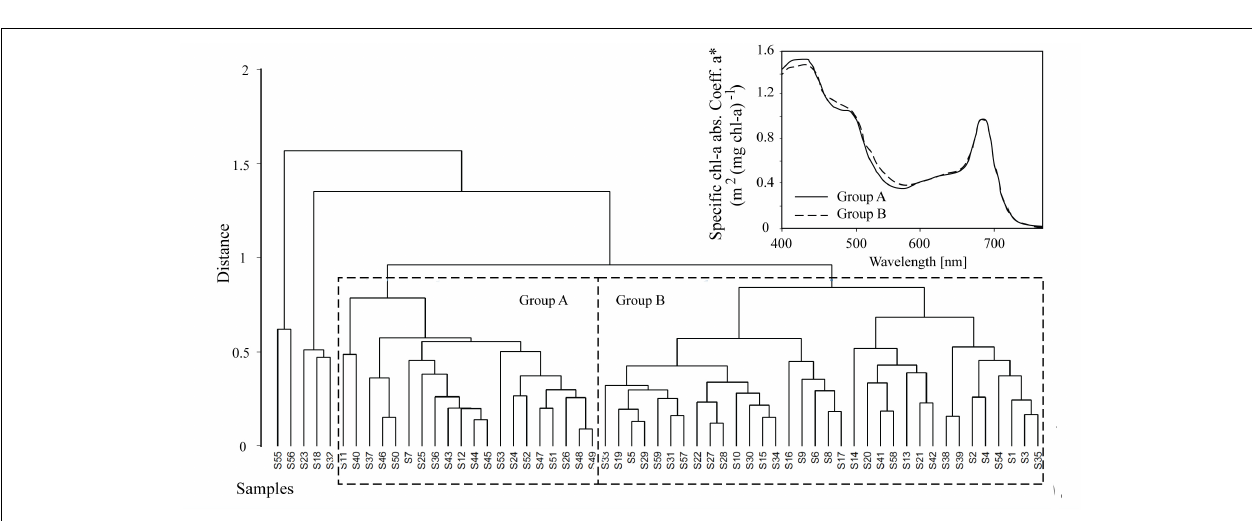
FIGURE 3 | Hierarchical cluster analysis of absorption spectra from 60 samples where Groups A and B are shown for subsequent analysis. The average algae particulate absorption spectra normalized to the 670 nm peak for each of the two main Groups A and B is also shown for reference